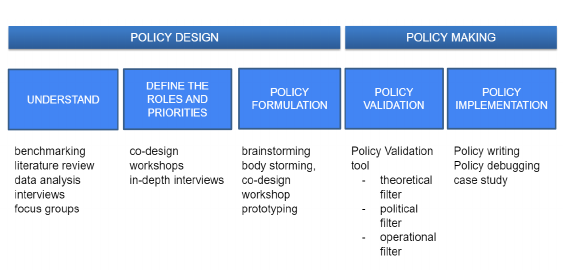
Fig. 1 . Policy Innovation Process